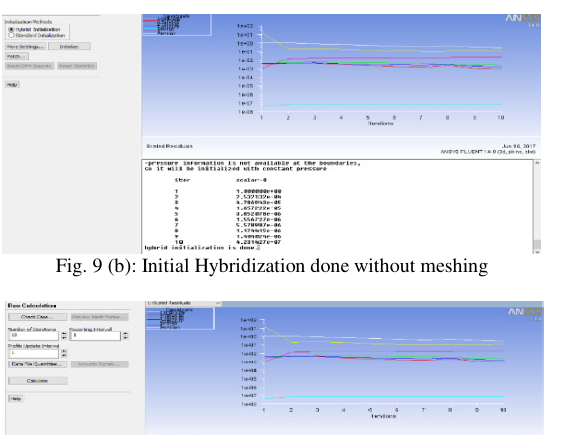
Fig. 10: Contour of pressure for simulation With warning error simulation was done for straight crossed microchannel at 182.15 aspect ratio. Error free simulation was done for this microchannel at 19.6 aspect ratio. It means ANSYS work best with these dimensions and beyond for straight crossed microchannel.